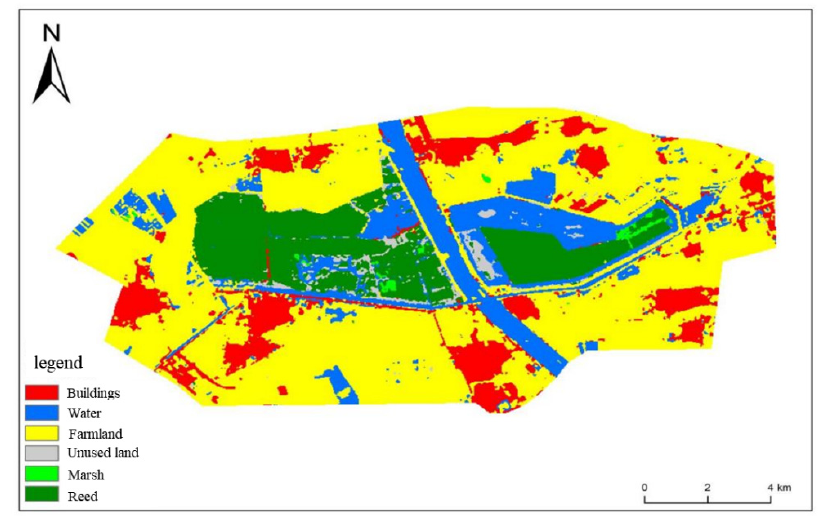
Figure 3. Classification of land-use types.